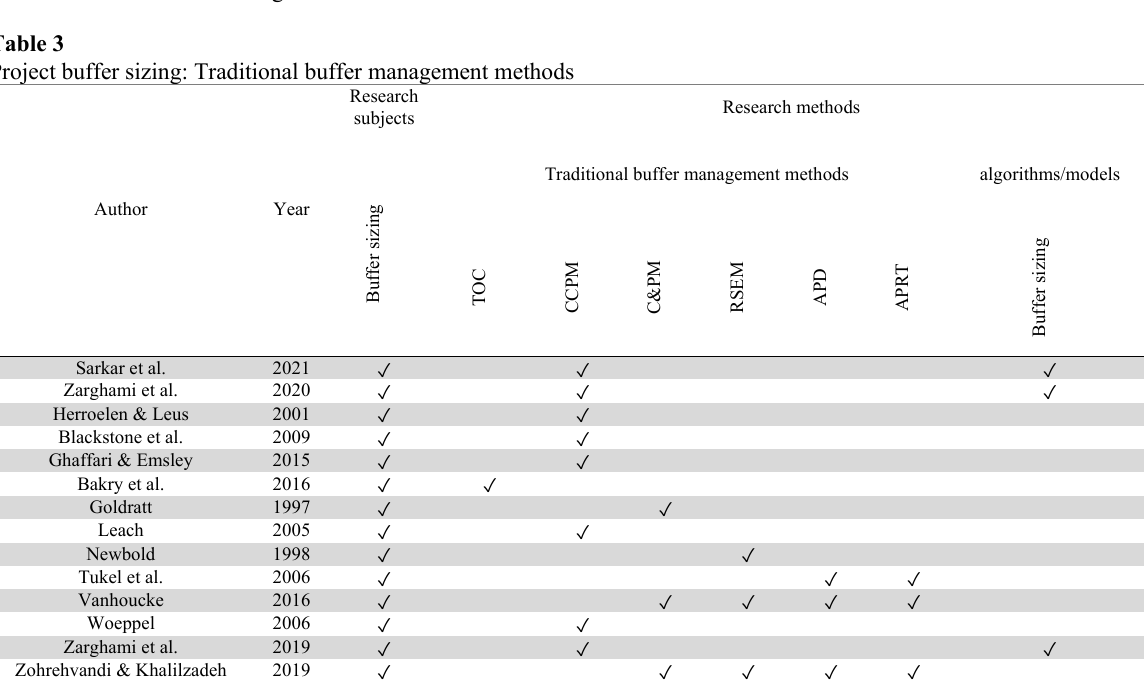
Research subjects Research methods Buffer sizing Models/Methods Buffer sizing